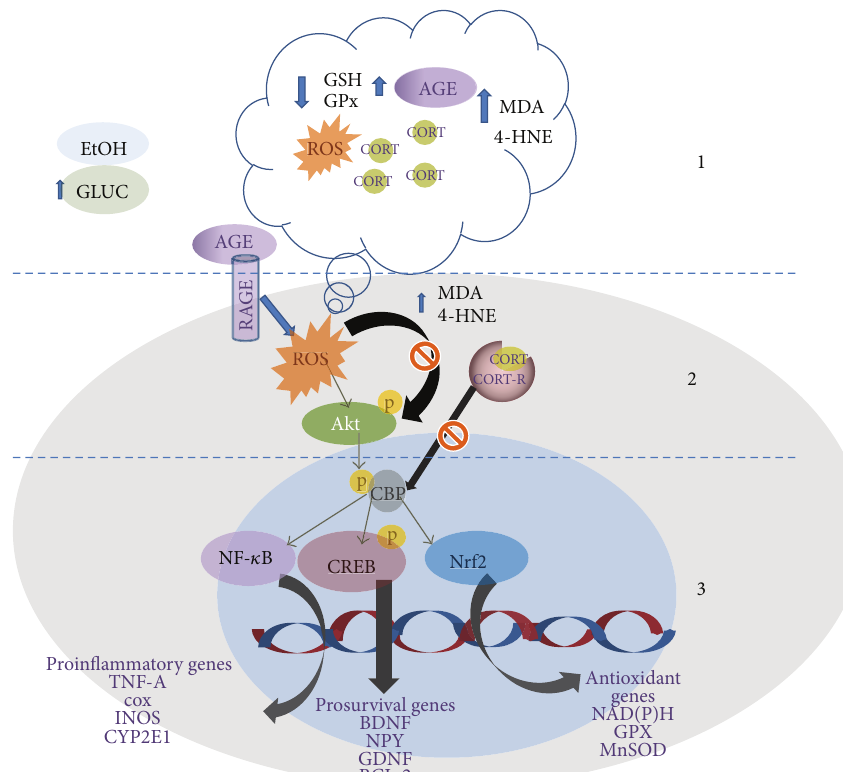
Figure 1: Scheme summarizing common pathways implicated in oxidative stress, inflammation, and antioxidant responses. 1.Circulating ethanol and high glucose levels lead to ROS production, antioxidant defense decay, AGE, and aldehyde production (4-HNE, MDA). Alterations on the hypothalamic pituitary axis (HPA) produce glucocorticoid release. 2. RAGE activation and ROS activate Akt but increased levels of 4-HNE; MDA can block Akt phosphorylation. 3. CBP is an acetyl transferase (HAT) that depends on p-Akt. CBP is necessary for p-CREB, Nf- 𝜅 B, and Nrf2 allowing transcription of proinflammatory or anti-inflammatory genes. Glucocorticoid receptors inhibit CBP activity blocking transcription. Since Nf- 𝜅 B, p-CREB, and Nrf2 compete for CBP the balance on proinflammation versus